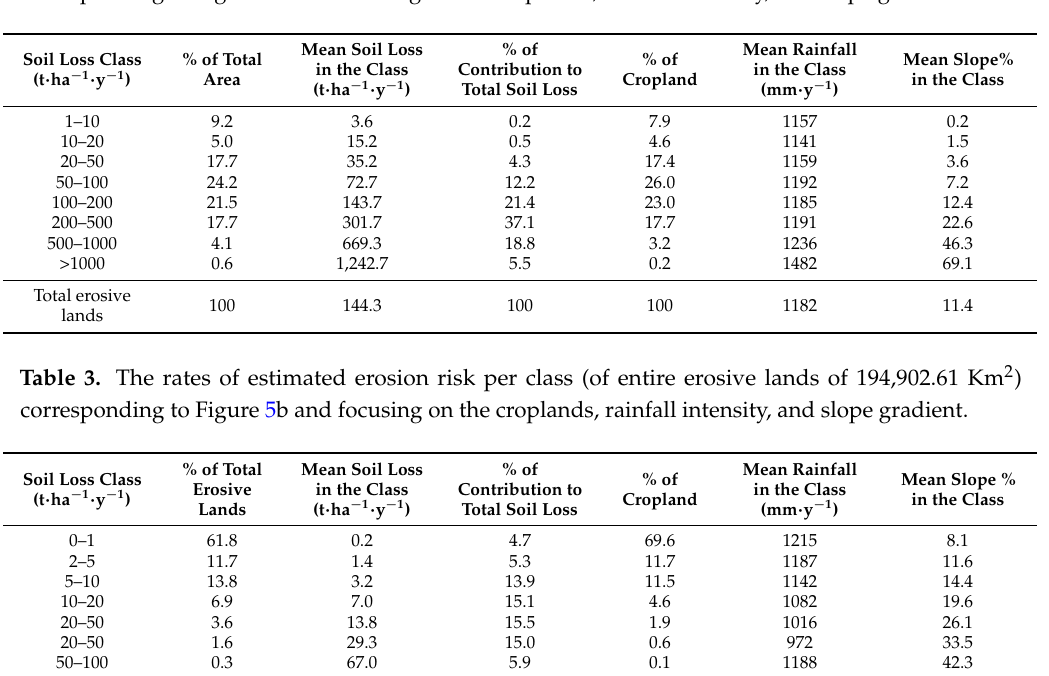
Figure 5. Maps of the soil erosion risk by water in the whole erosion-prone area (194,902.61 km 2 ) of Uganda in 2014: ( a ) potential soil erosion risk and ( b ) estimated soil erosion risk. Table 2. The rates of potential erosion risk per class (of the entire erosive lands of 194,902.61 Km 2 ) corresponding to Figure 5a and focusing on the croplands, rainfall intensity, and slope gradient.